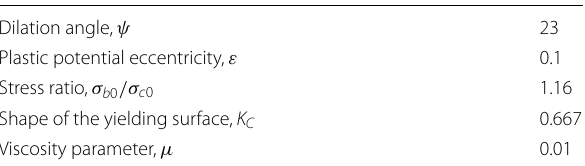
Table 11 Plasticity parameters used in CDP model. Dilation angle, ψ